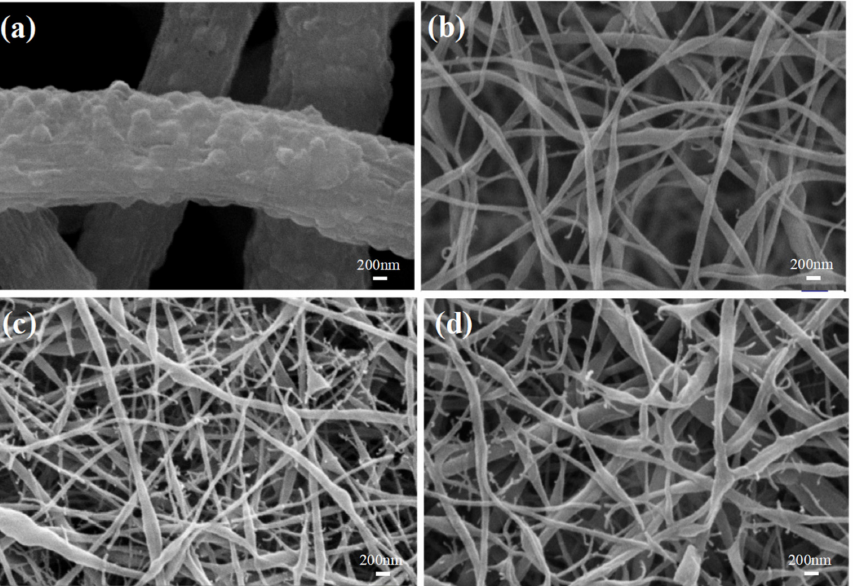
Figure 3. SEM images of PVDF/SDS nanofiber membranes with different SDS concentrations: